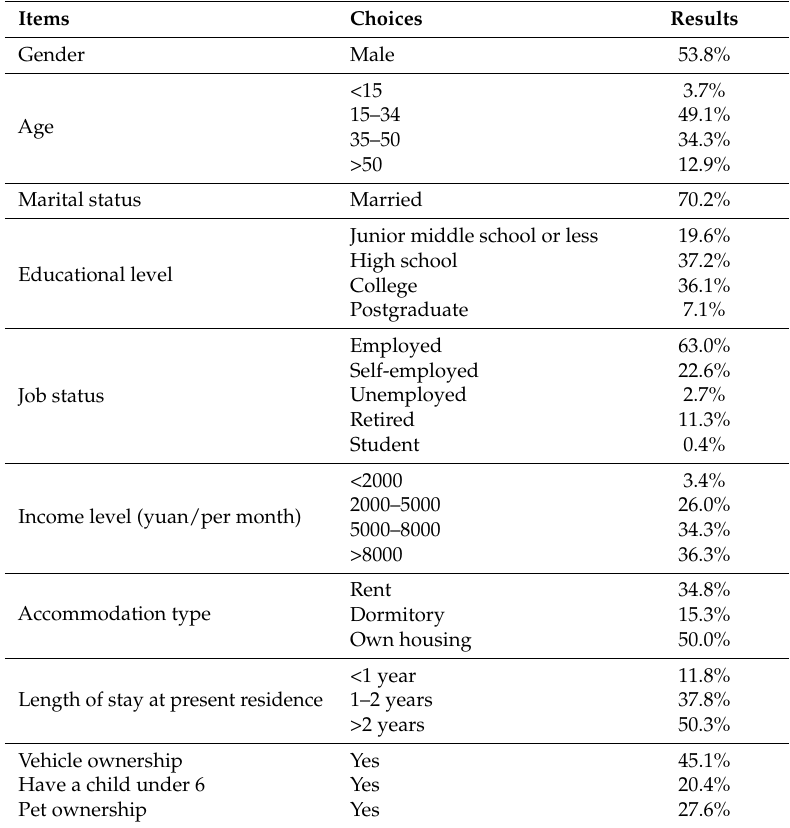
Table 1. Sociodemographic characteristics of the study